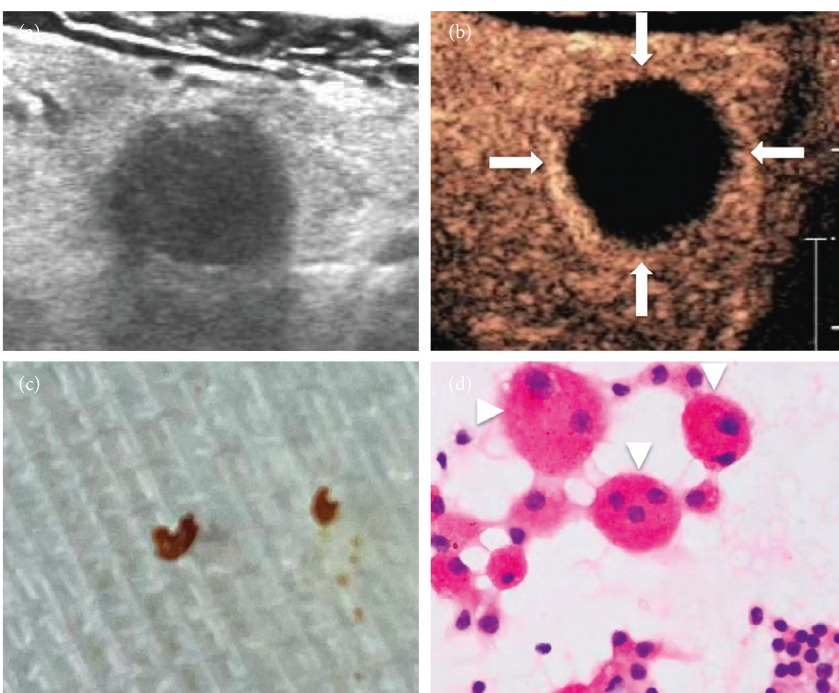
Figure 3: (a) A 63-year-old male, who was found to have a very hypoechoic solid nodule of the thyroid, with ill-defined margin and posterior echo attenuation. It was classified as TI-RADS 4. (b) CEUS showed no enhancement at all in most areas of this nodule, and only the edge of the nodule showed regular annular enhancement with clear margin. (c) The aspirate of the FNAB was a dry brown substance. (d) Multinucleated giant cells and hemosiderin were easily to be seen in cell pathology